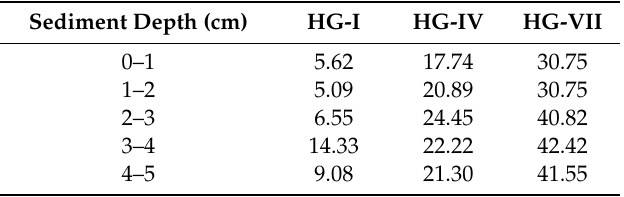
Table 4. Median gain sizes ( µ m) in the uppermost sediment layers at HG-I (1280 m), HG-IV (2500 m), and HG-VII (4000 m) in summer